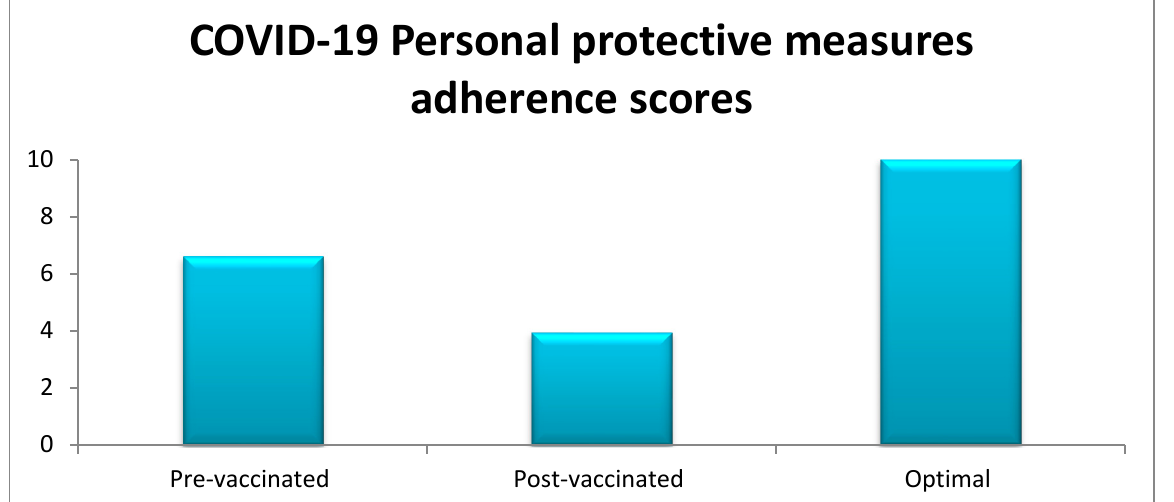
Figure 2. Optimal adherence scores regarding personal protective measures against COVID-19 and comparisons between the scores of pre-vaccinated and post-vaccinated participants in the Jazan region of Saudi Arabia.